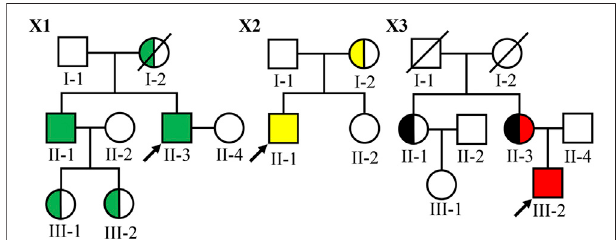
FIGURE1| PedigreeofthreeChinesefamilieswithXLAS.Filledsymbols represent affected individuals (green: the COL4A5 c.1424 – 4C > G variant carriers; yellow: the COL4A5 c.2777G > T p.(Gly926Val) variant carriers; black: the COL4A5 c.1552G > A p.(Gly518Arg) variant carriers and red: the COL4A5 c.4298 – 2A > T variant carrier). The symbol with a slash corresponds to a decreased individual. Arrow indicates the